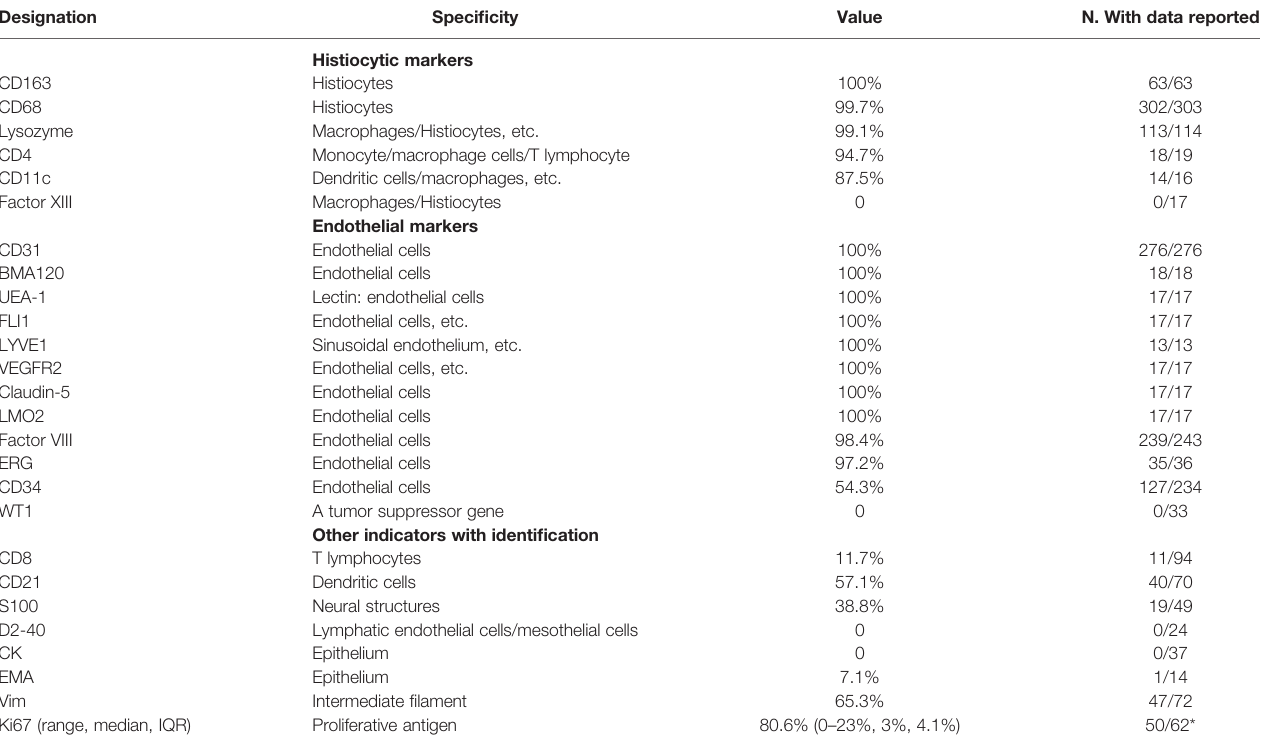
TABLE 5 | Summary of immunohistochemical characteristics of